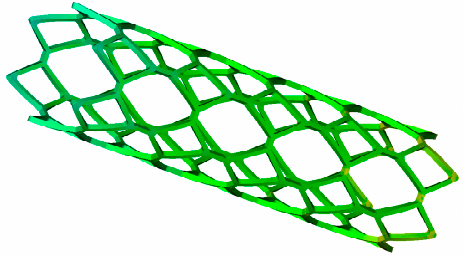
Figure 3. Generic polymeric stent with straight bridges.